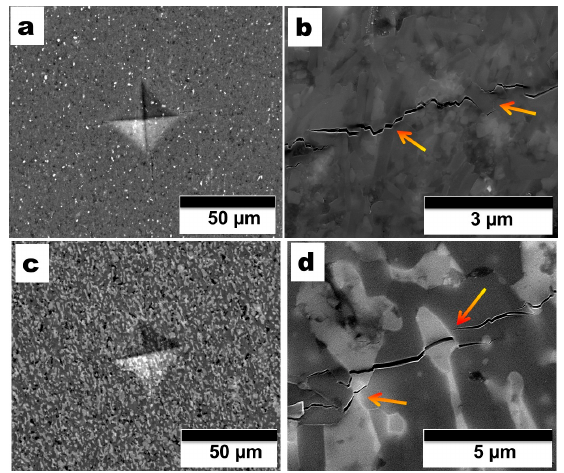
Figure 9. Representative Vickers indentation pattern showing cracks and toughening mechanisms.